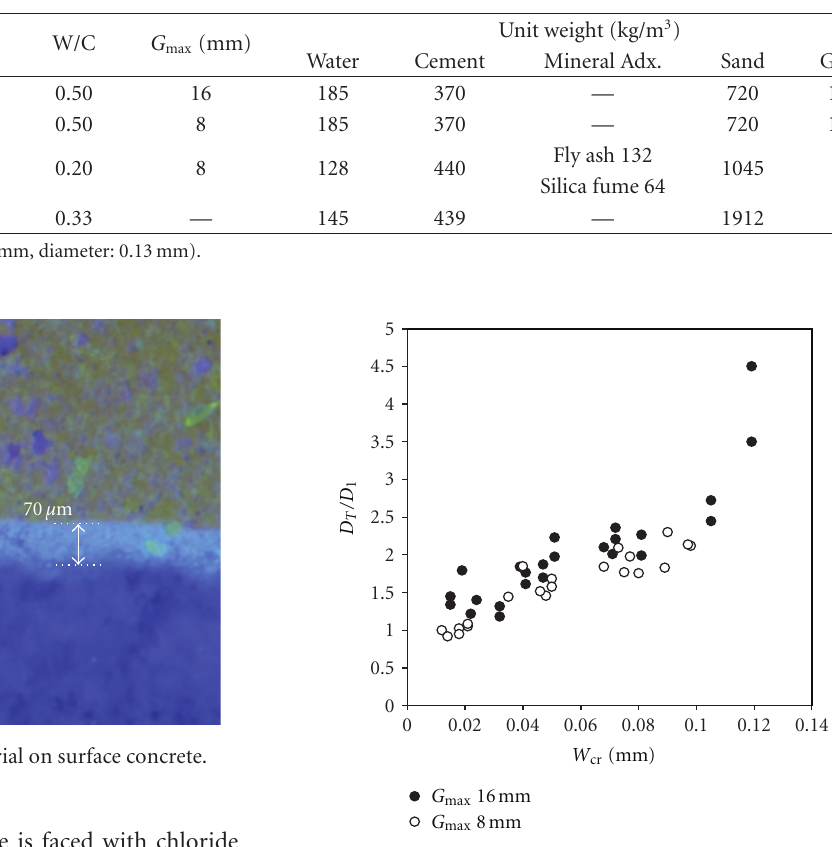
Figure 6: Relative di ff usivity versus G max